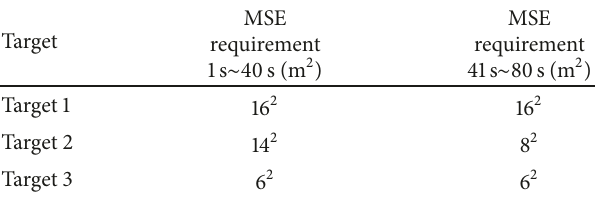
Table 3: Low MSE thresholds for multiple targets